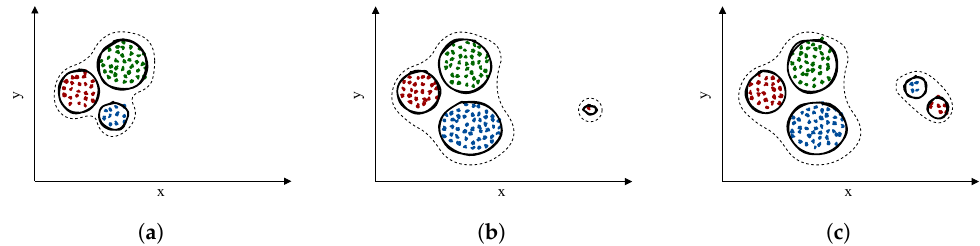
Figure 3. Clustering process in Macro SOStream. ( a ) Macrocluster with arbitrary form. ( b ) Macro- clusters with one and many microclusters. ( c ) Evolution of macroclusters over